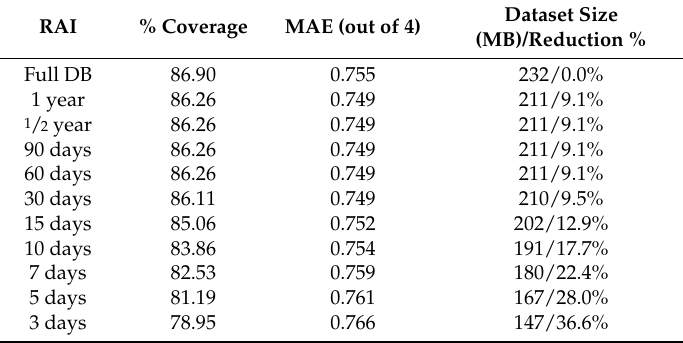
Table 5. Amazon “Books” dataset